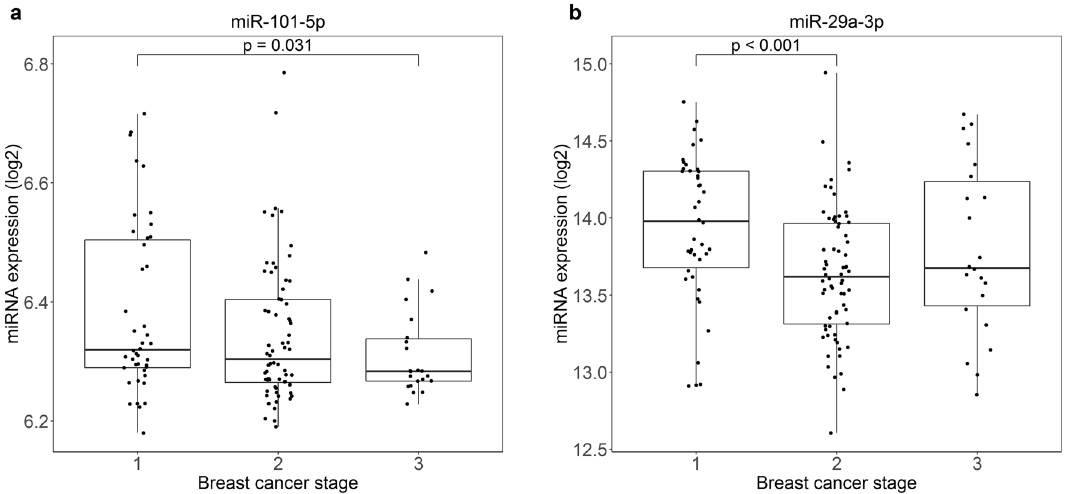
Figure 3. Expression of miR-101-5p and miR-29a-3p decrease with advanced breast cancer stage. miRNA expression and breast cancer stage in HER2+ breast cancer patients from the METABRIC dataset. The boxplots show miRNA expression level on the y-axis and breast cancer stage on the x-axis. There is a significantly higher expression of miR-101-5p in stage 1 patients versus stage 3 patients ( p = 0.031; ( a )) and of miR-29a-3p in stage 1 patients versus stage 3 patients ( p < 0.001; ( b )). p -values resulting from Wilcoxon tests.